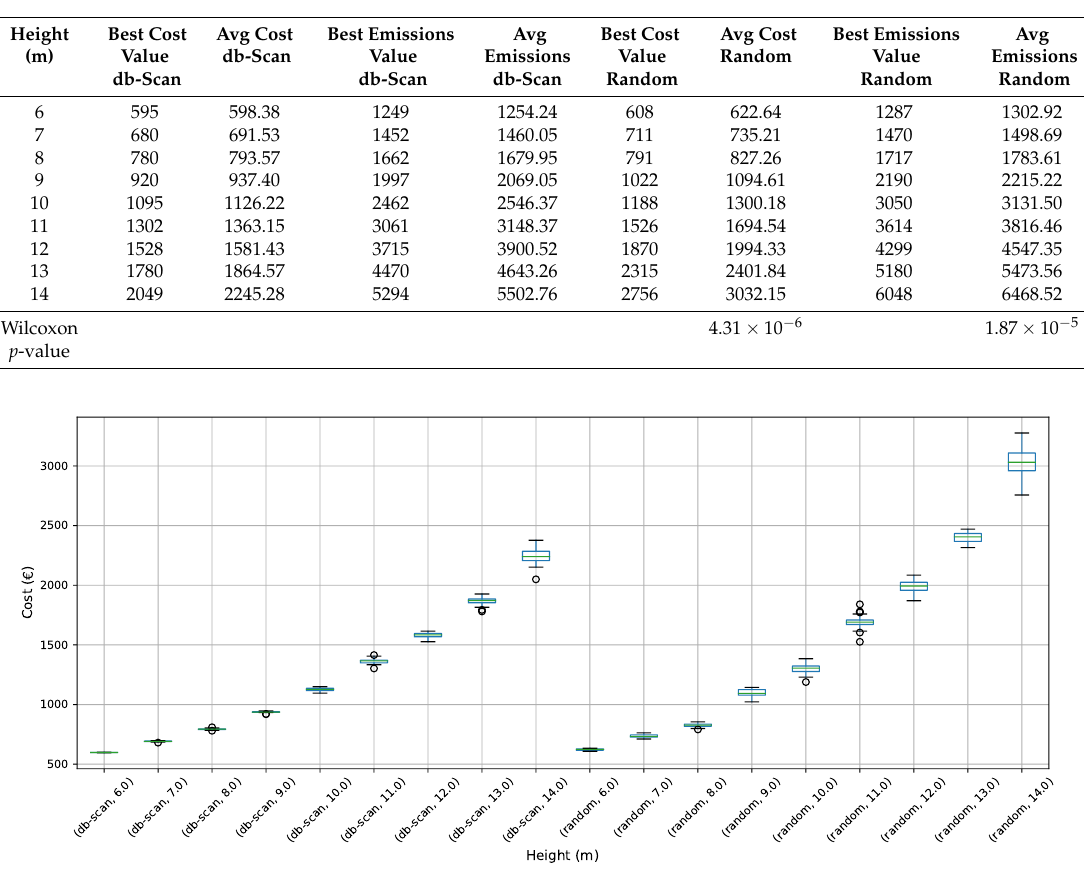
Table 5. Comparison between random and db-scan operators in cost and emission optimization.